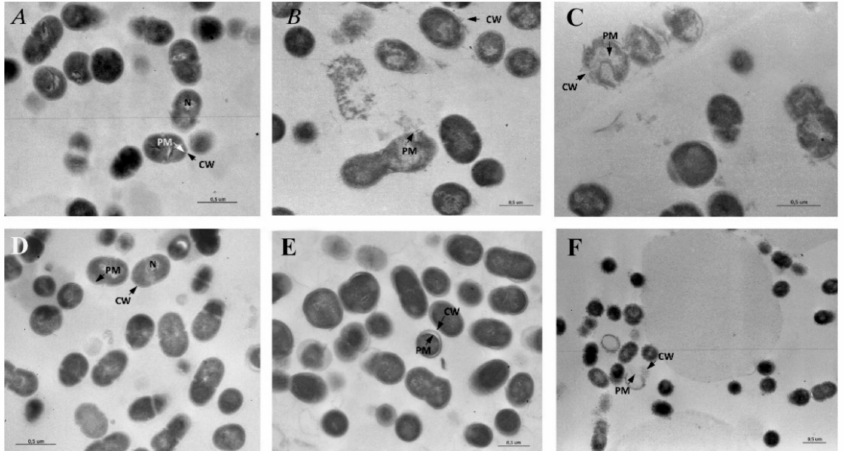
Figure 4. ( A ) Untreated S. mutans shows an intact and well-defined cell wall (CW), plasma membrane (PM), and cytoplasmic space with a nucleoid (N). ( B ) When treated with TC essential oil, S. mutans appears swollen and degenerated with clear evidence of rupture of the CW and PM up to cell disintegration. ( C ) After contact with CLP extract, S. mutans displays features of degeneration comparable to those described in the cells treated with TC essential oil.( D ) Regardless of the extract loaded, after contact with liposomes, S. mutans showed a well-conserved morphology in comparison to the control, whereas ( E ) after contact with glycerosomes, the cells appear swollen and show the enlargement of the wideness between CW and PM, and ( F ) after contact with PG-PEVs, the cells are surrounded by dense globules infiltrating the CW with perforation of the CW and PM. Other cells appear clearly disintegrated in the